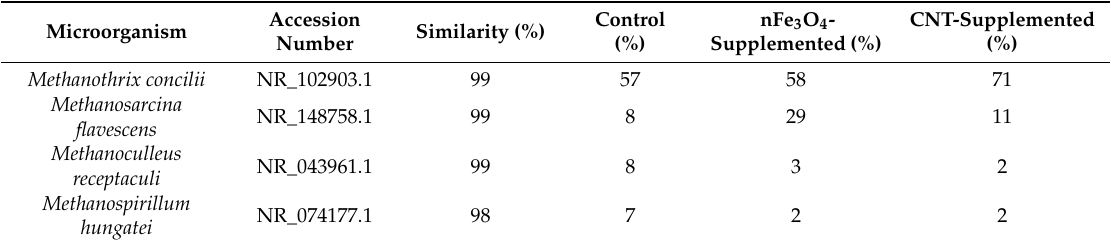
Table 2. Archaeal communities in species level identification of the dominant sequences control, nFe 3 O 4 -supplemented and CNT-supplemented batches.